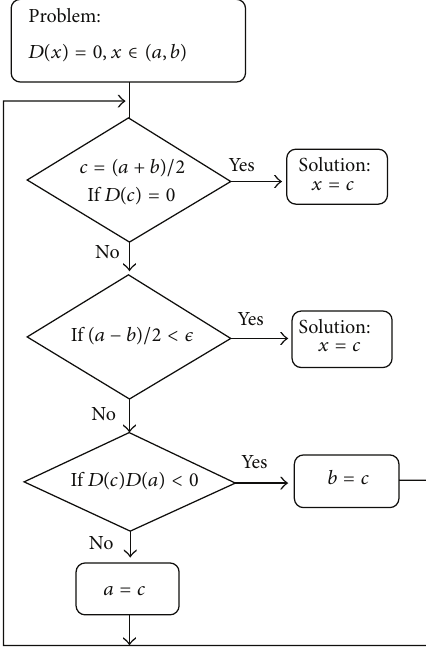
Figure 1: Flow chart for bisection